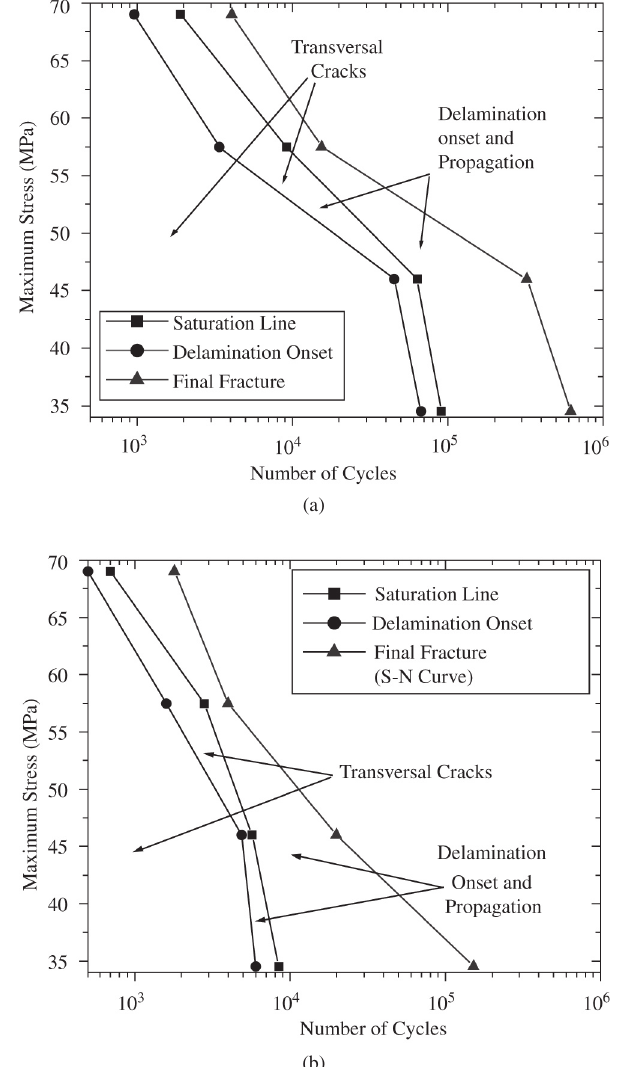
Figure 2. Laminate C12 ( σ = 69 MPa, R = 0.1, N = 18700 cycles, number max of cycles to rupture, N = 21200 cycles). 0